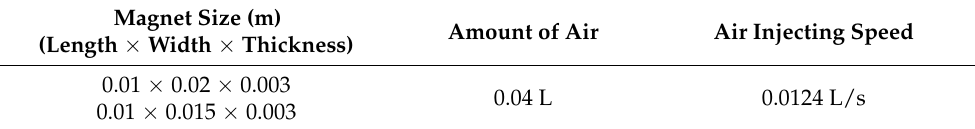
Figure 17. Result of changing direction test.